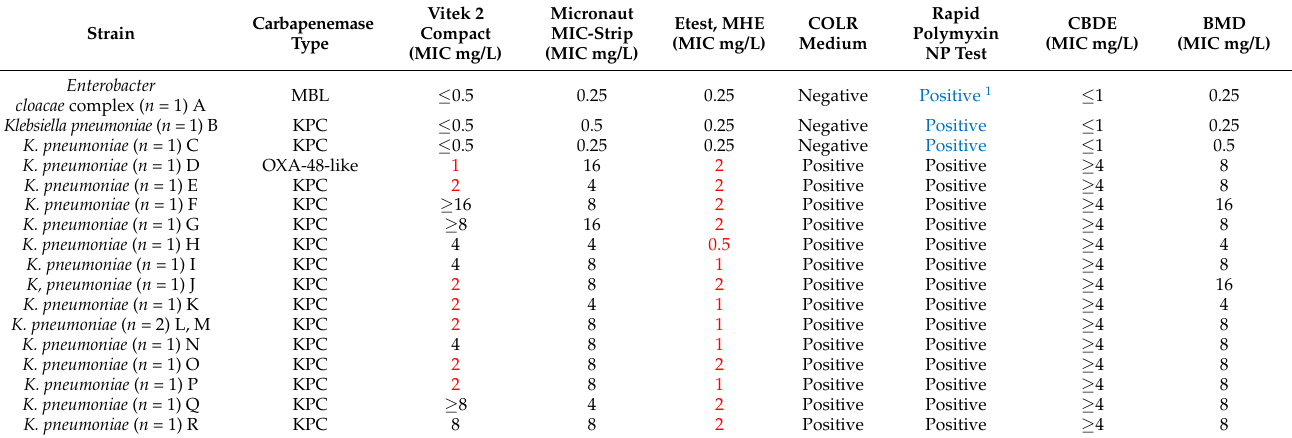
Table 3. The VMDs and MDs identified in all isolates in comparison with the